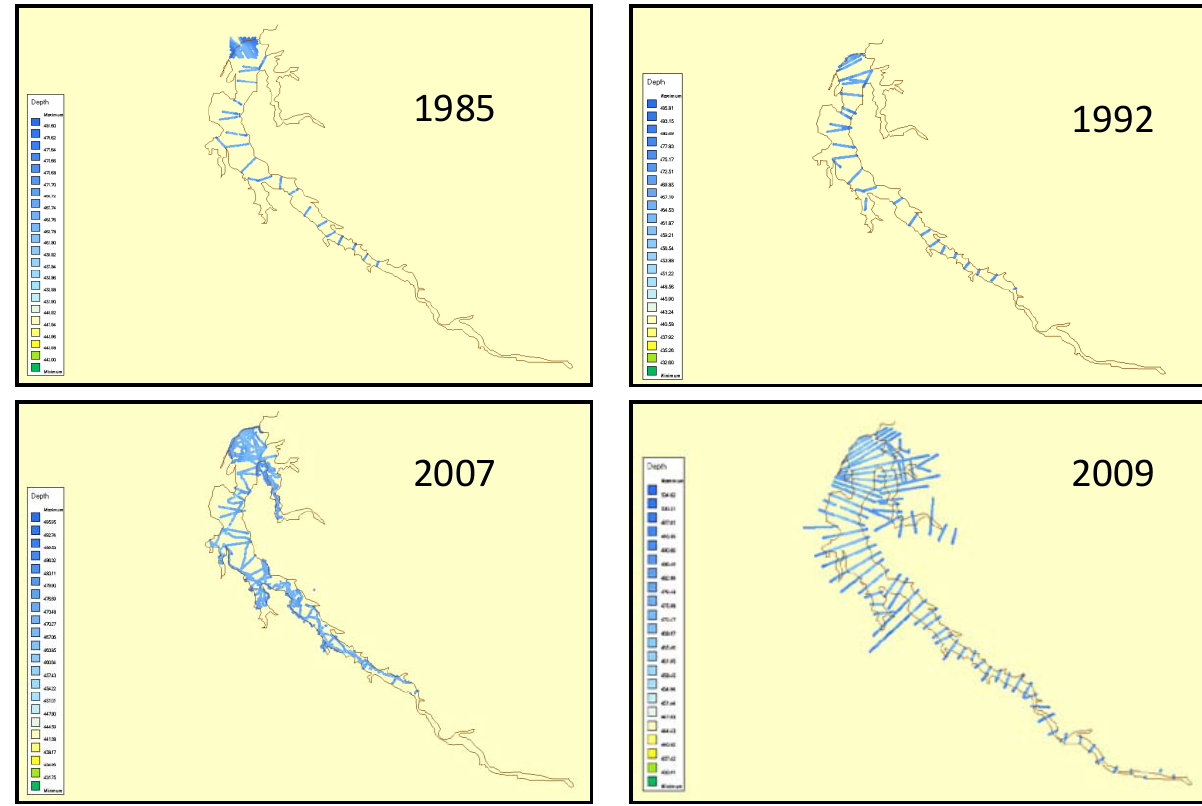
Figure 3. Available bathymetric surveys (cross sections). Fig. 3. Available bathymetric surveys (cross-sections). Table 1. Storage capacity of Roseires Reservoir in × 10 6 m 3 at different years as a function of level, derived from measured bed